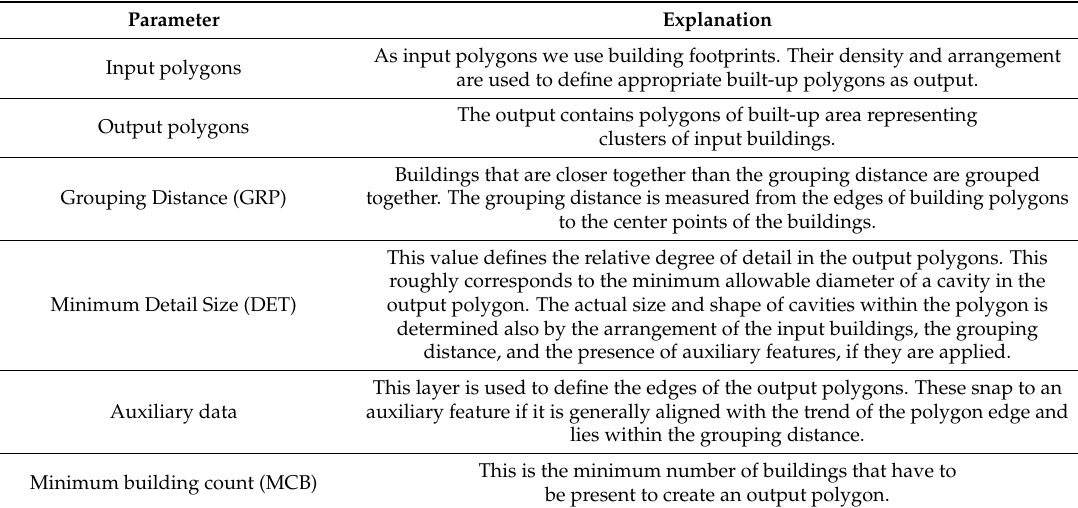
Table 1. Description of the parameters of the “Delineate Built-Up Area” tool (taken and revised from [28]).